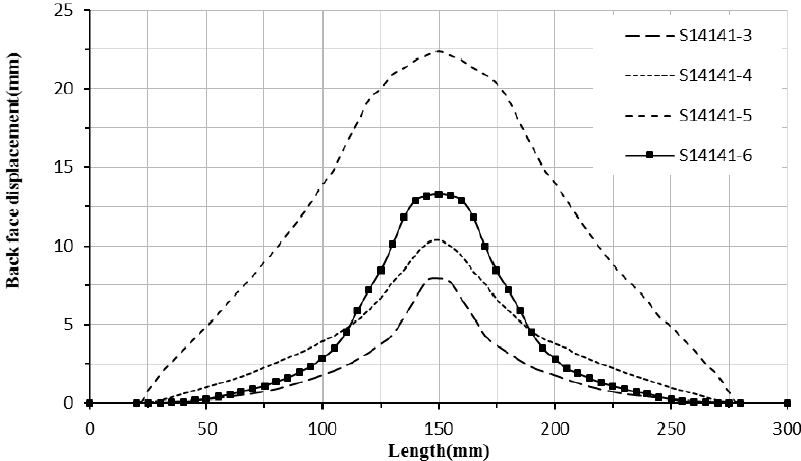
Figure 12. The back face deformation for non-perforated samples (i.e., general failure mode I).